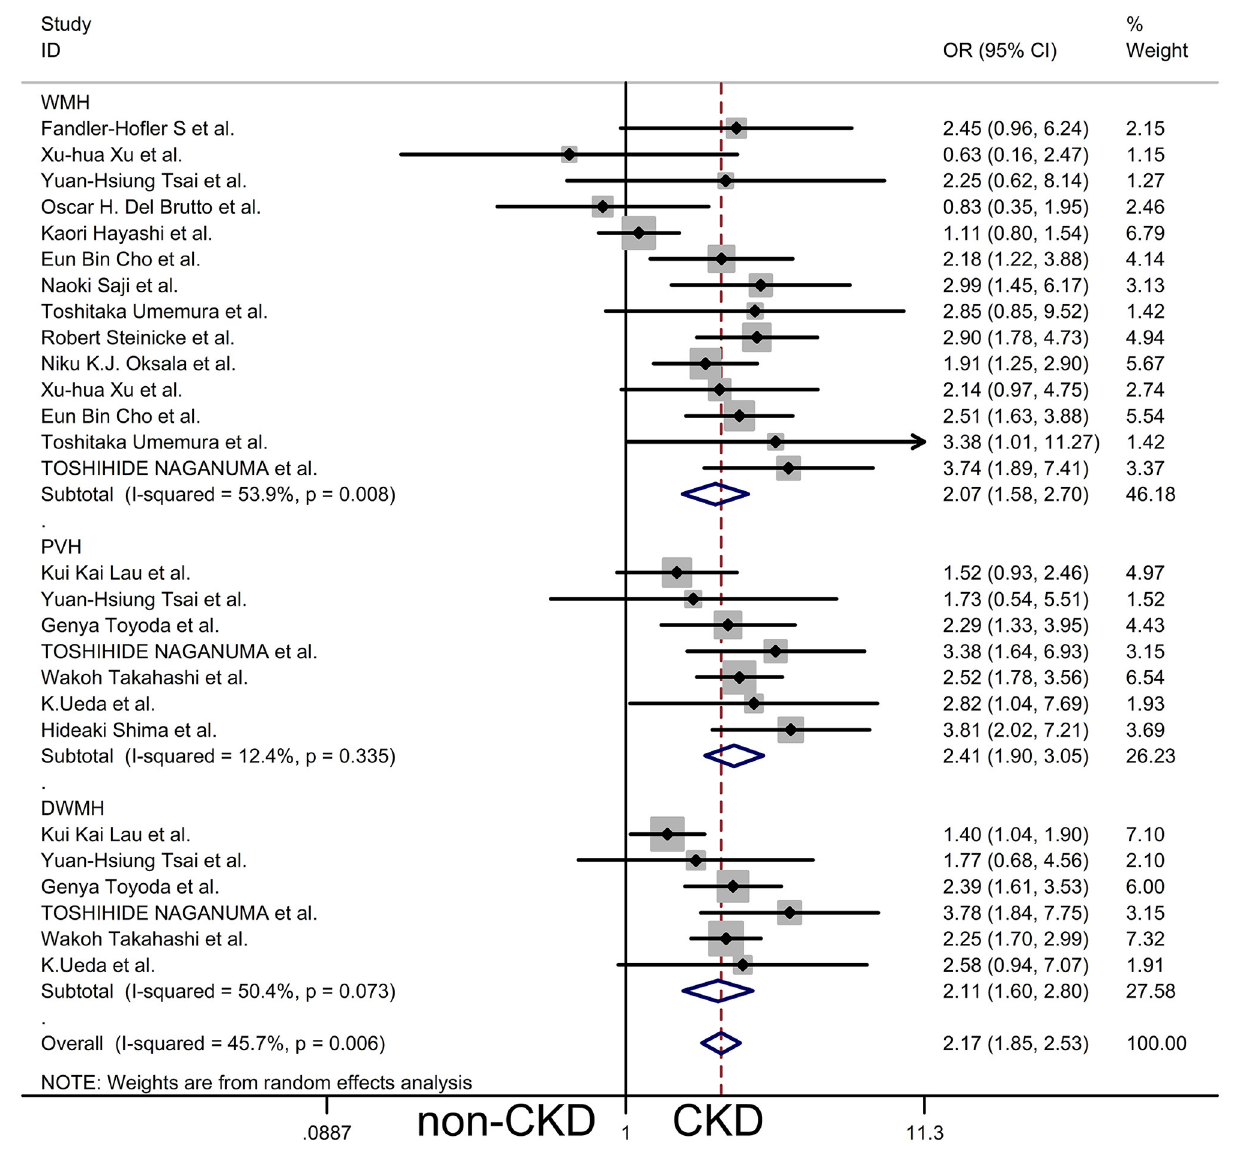
FIGURE 2 | The subgroup analysis of a forest plot of comparison of CKD vs.